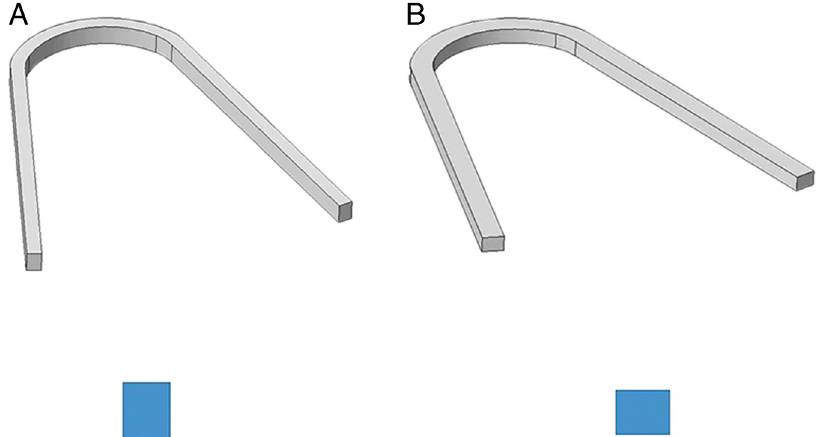
Figure 14. ( A) ribbon-wise arch wire; (B) traditional orthodontic wire: the ribbon-wise arch wire has a greater width than height in cross-section which makes the wire harder to bend in the vertical